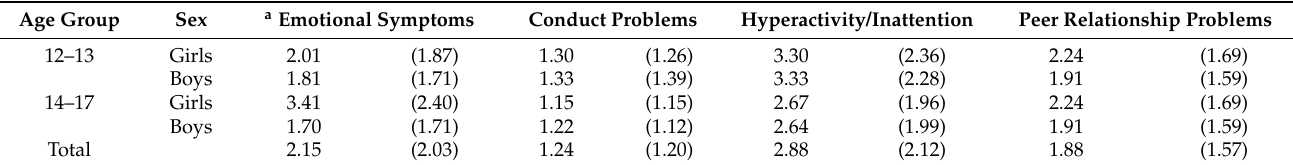
Table A3. Distribution of SDQ validation measure in the 2018 sample (N =